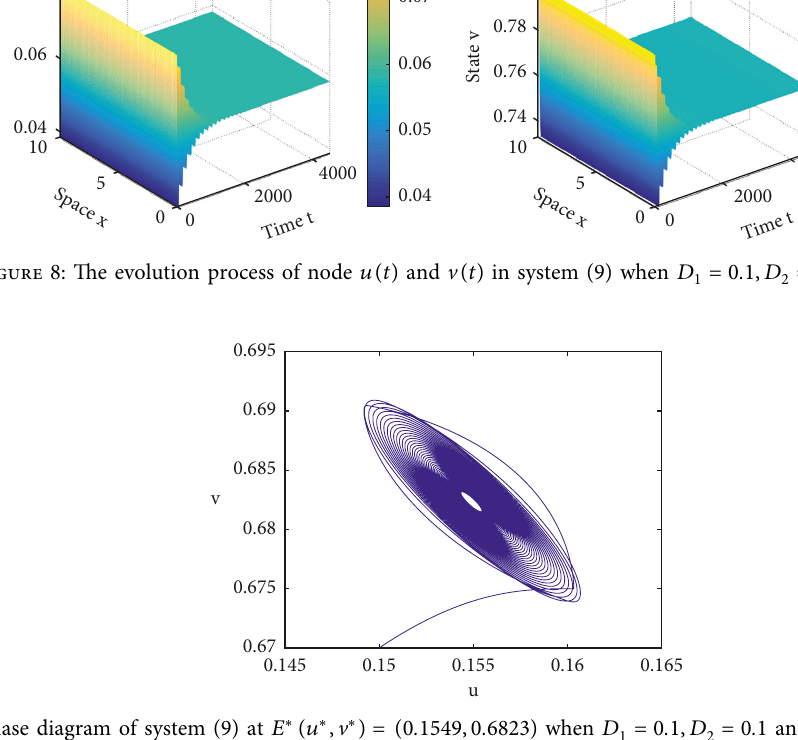
� 0 . 1 , D � 0 . 1 and τ � 23 < τ 0 1 2